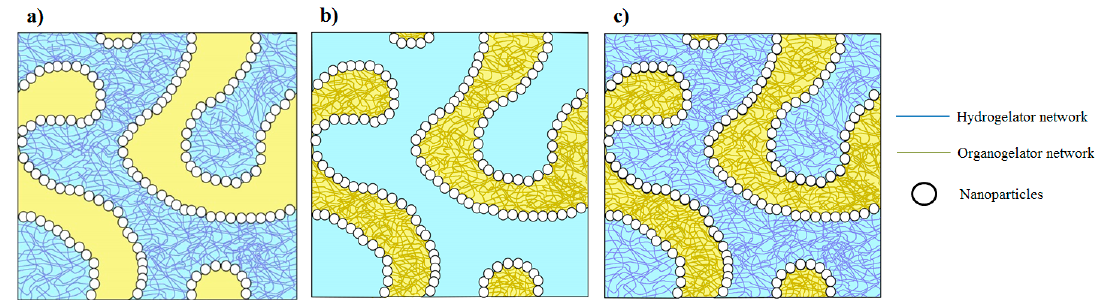
Figure 3. Proposed schematics of bijel systems with ( a ) structured water phase, ( b ) structured oil phase, and ( c ) both structured phases.